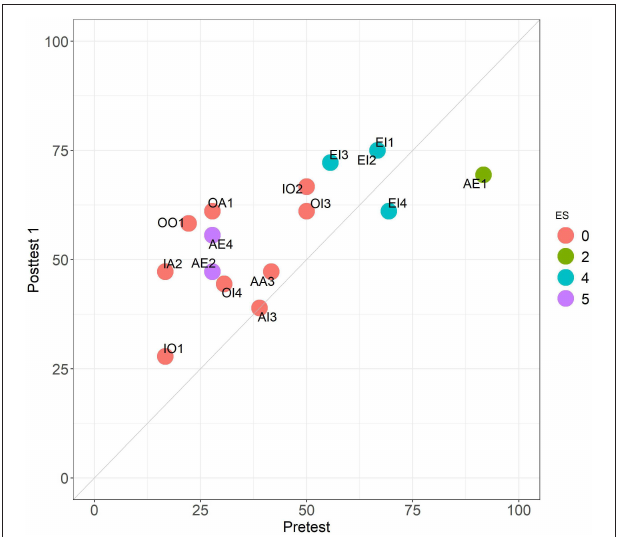
FIGURE 10 | Comparison between the pretest ( N = 36) and posttest 2 ( N = 15) in Experiment 2. Performance across the 16 problems of set 1. Colors follow the ES classification. Problems in class 5 (AE2 and AE4) are hidden behind OA1.